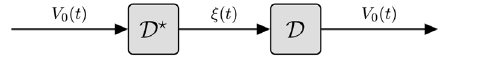
Figure 9. Description of the pre-inverse system D H . The tandem system D (cid:7) D H generates the